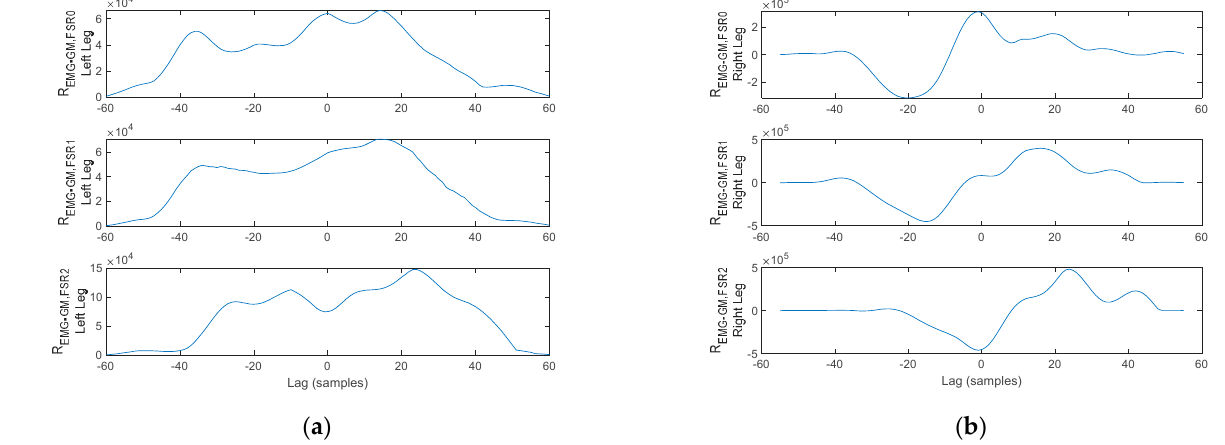
Figure 20. Cross-correlation of the GM and FSR signals plotted in Figure 17 for the ( a ) left foot and ( b ) right foot.